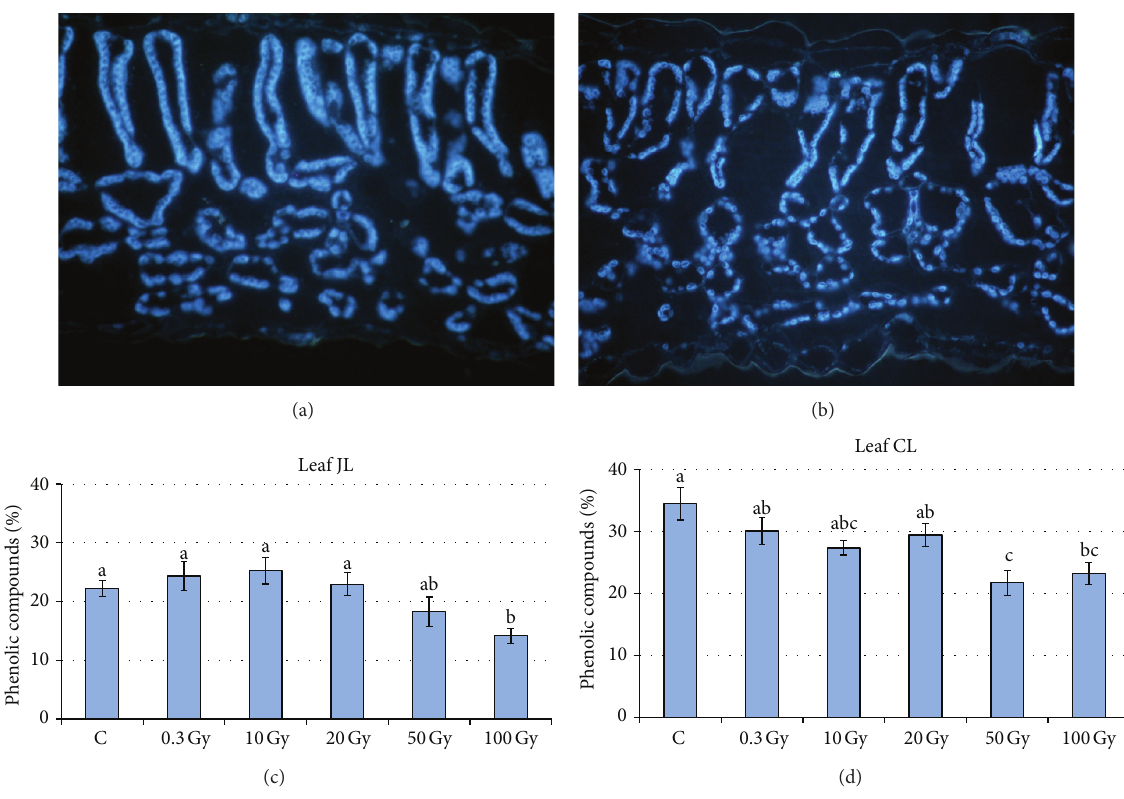
Figure 4: Epifluorescence microscopy views of lamina cross sections of S. lycopersicum L. “Microtom” compound leaves from plants developed from control (a) and 100 Gy irradiated seeds (b). Phenolic compounds along chloroplast membranes are autofluorescent. Percent of mesophyll occupied by phenolic compounds (%) is shown in (c) and (d) for juvenile (JL) and compound (CL) leaves, respectively. Mean values and standard errors are reported ( 𝑛 = 15 ); different letters correspond to significantly different values after multiple comparison tests ( 𝑃 < 0.05